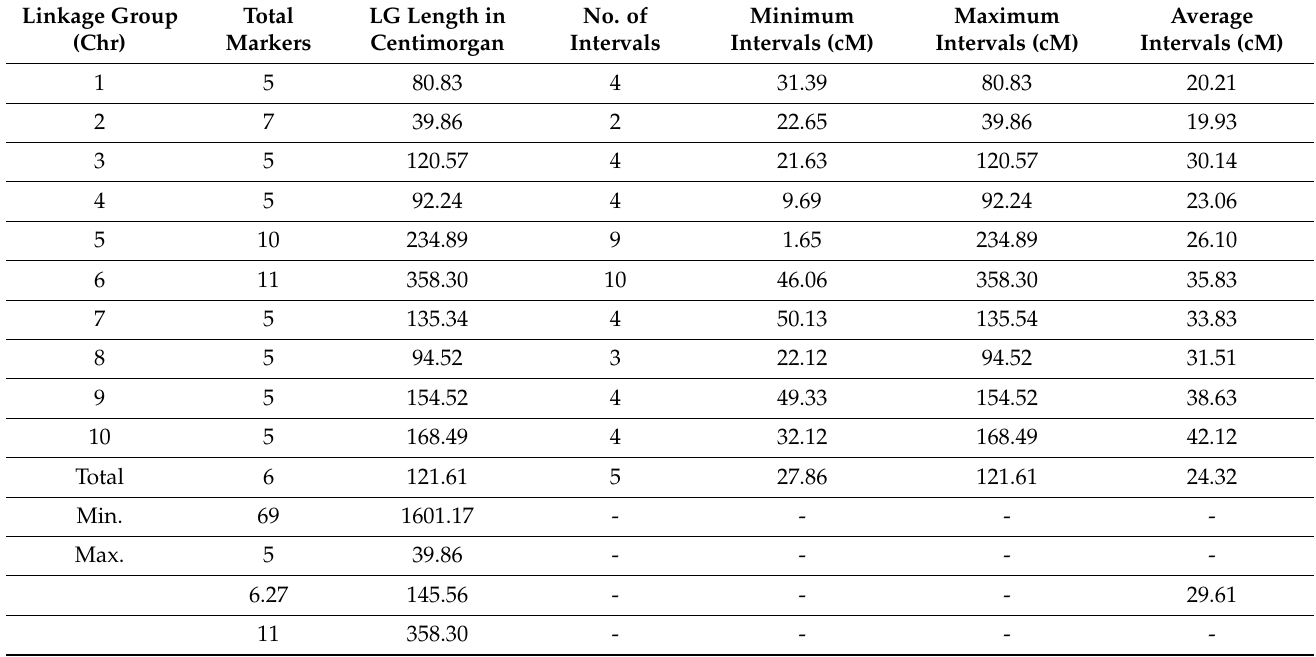
Table 1. The description of mapped SSR-markers and the genetic distance of linkage groups on the linkage map of